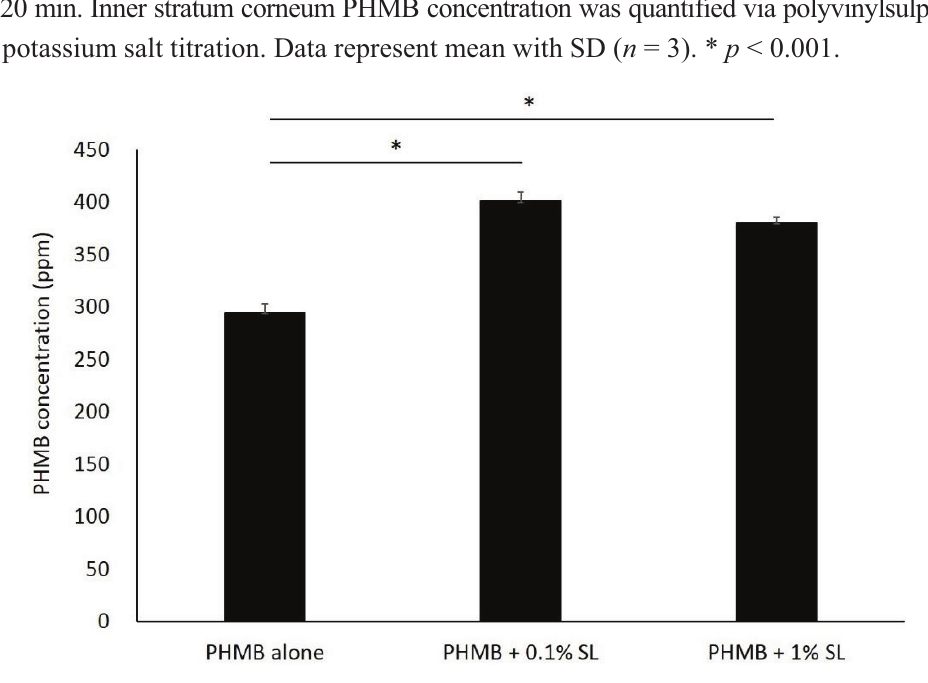
Figure 2. Cytotoxicity of PHMB with sophorolipid. An MTT assay was used to determine cytotoxicity. Cell viability% = [(mean optical density of the sample − blank)/(mean optical density of the control − blank)] × 100. Data represent mean with SD ( n = 3). * p < 0.01, ** p < 0.001, compared to the baseline